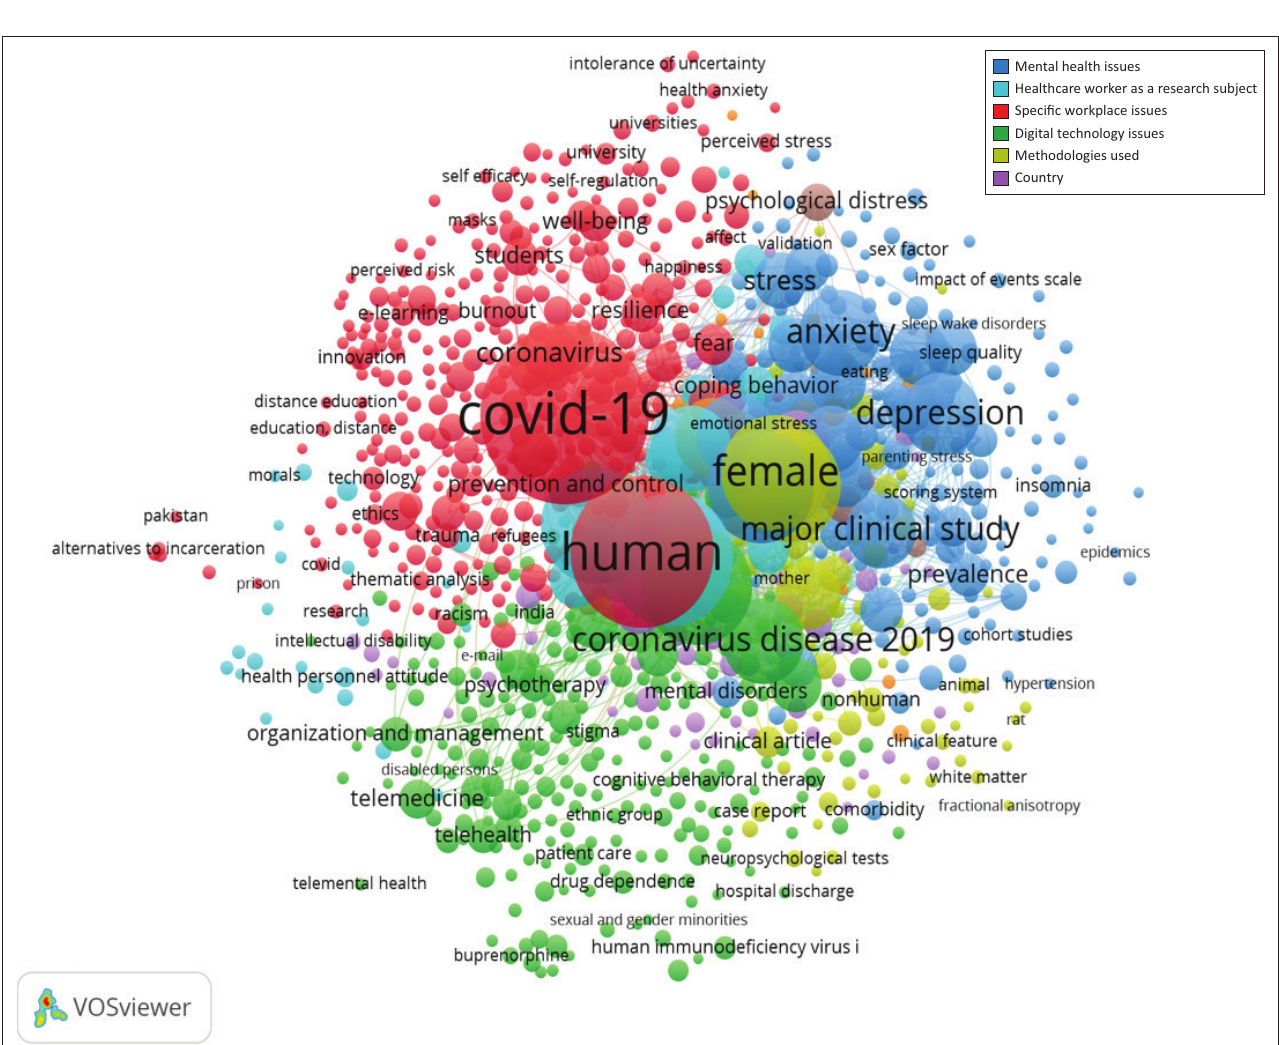
FIGURE 3: The cluster density